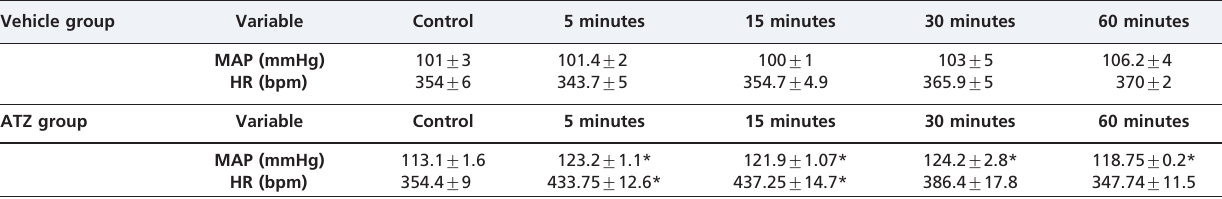
Table 1 - Baseline level of mean arterial pressure (MAP) and heart rate (HR) in Wistar rats treated with vehicle (vehicle group: N= 7) and Wistar rats treated with ATZ (ATZ group: N= 8). Vehicle